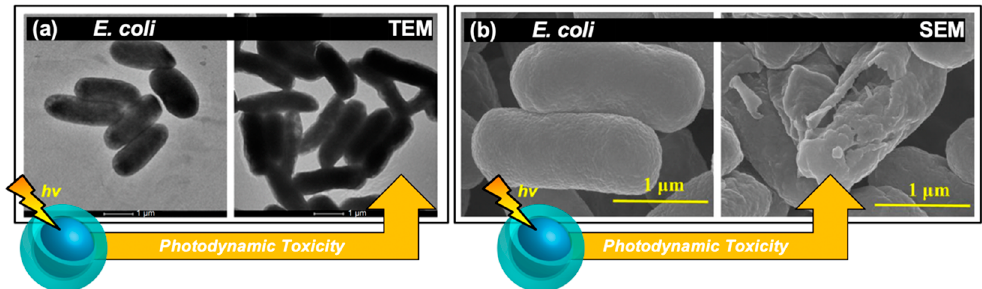
Figure 5. Morphological changes in bacterial cells exposed to carbon nanodot photosensitizers. ( a ) Transmission electron microscopy (TEM) images of E. coli cells after ( left ) light exposure only and ( right ) after light-exposure in carbon dot treated samples. ( b ) Scanning electron microscopy images displaying E. coli cells both ( left ) pre and ( right ) post exposure for carbon dot treated samples. For additional details regarding the reported studies, the reader is referred to Table 1 of the main